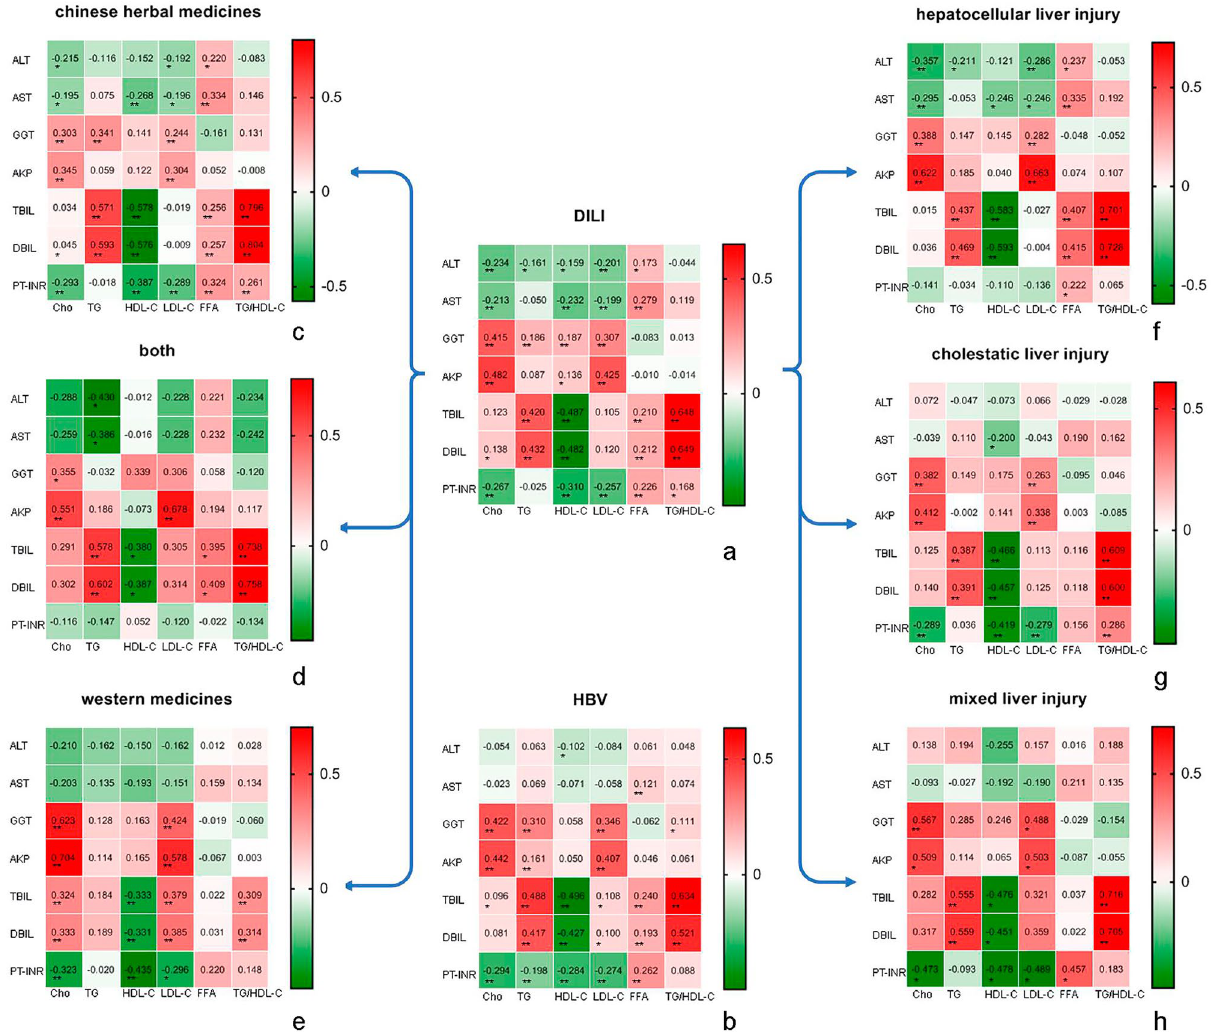
Figure 4. The correlation between liver function and serum lipid levels for different classes of DILI and acute hepatitis B groups. TG triglyceride, Cho cholesterol, LDL-C low-density lipoprotein cholesterol, HDL-C high- density lipoprotein cholesterol, FFA free fatty acid, ALT aminotransferase, AST Aspartate transaminase, GGT gamma-glutamyl transferase, AKP alkaline phosphatase, TBIL total bilirubin, DBIL direct bilirubin, PT-INR International normalized ratio of prothrombin time, DILI drug induced liver injury. ( a ) the correlation between liver function and serum lipid levels of DILI patients. ( b ) the correlation between liver function and serum lipid levels of HBV patients. ( c ) the correlation between liver function and serum lipid levels of DILI patients with herbal medicine use. ( d ) the correlation between liver function and serum lipid levels of DILI patients with combined herbal and western medicine use. ( e ) the correlation between liver function and serum lipid levels of DILI patients with western medicine use. ( f ) the correlation between liver function and serum lipid levels of DILI patients with hepatocellular liver injury. ( g ) the correlation between liver function and serum lipid levels of DILI patients with cholestetic liver injury. ( h ) the correlation between liver function and serum lipid levels of DILI patients with mixed liver injury. *P ≤ 0.05, **P ≤